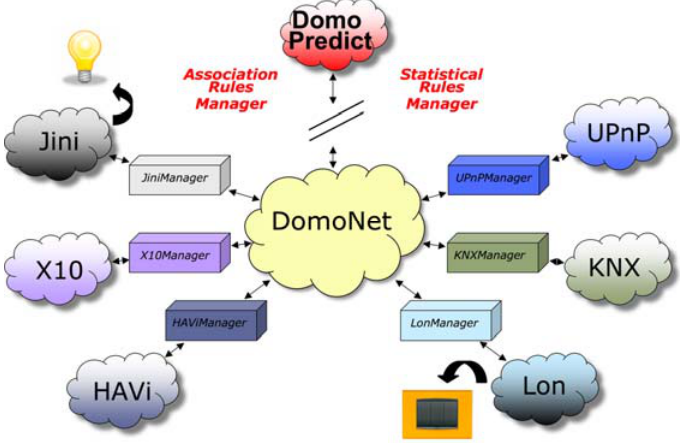
Figure 2. The DomoNet